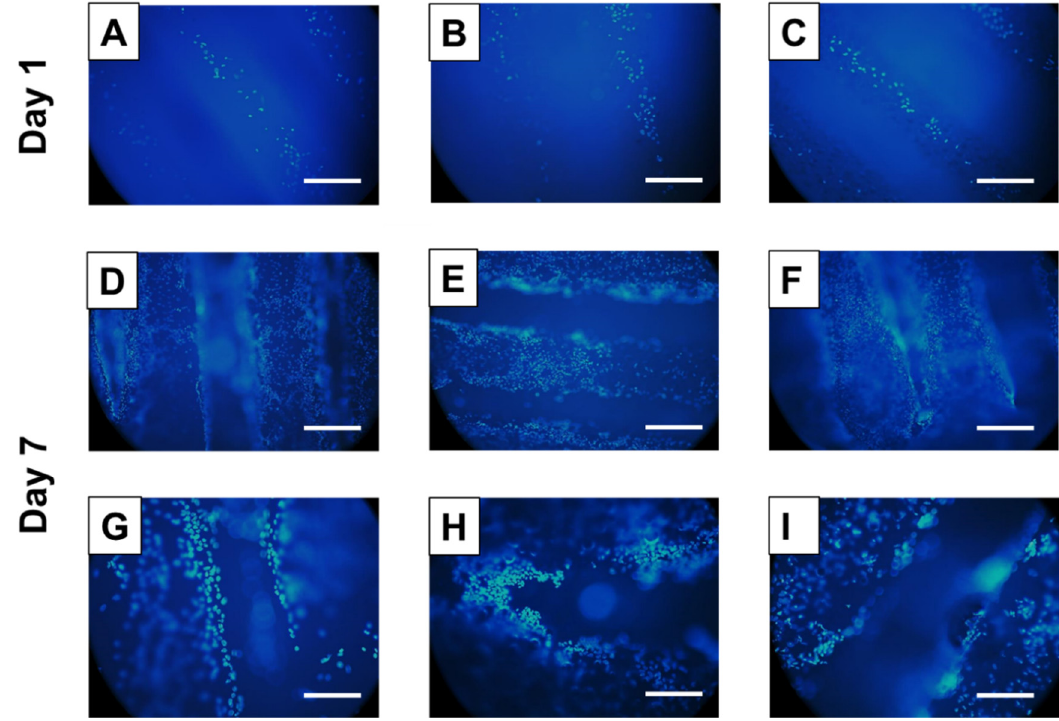
Figure 8. DAPI staining of U2OS cells seeded on PCL ( A , D , G ), PCL/10Sr-nHA ( B , E , H ) and PCL/20Sr- DAPI staining of U2OS cells seeded on PCL ( A , D , G ), PCL / 10Sr-nHA ( B , E , H ) and nHA ( C , F , I ) after 1 and 7 days in culture; (( A – F ) scale bar = 400 μ m; ( G – I ) scale bar = 200 μ m). PCL / 20Sr-nHA ( C , F , I ) after 1 and 7 days in culture; (( A – F ) scale bar = 400 µ m; ( G – I ) scale bar = 200 µ